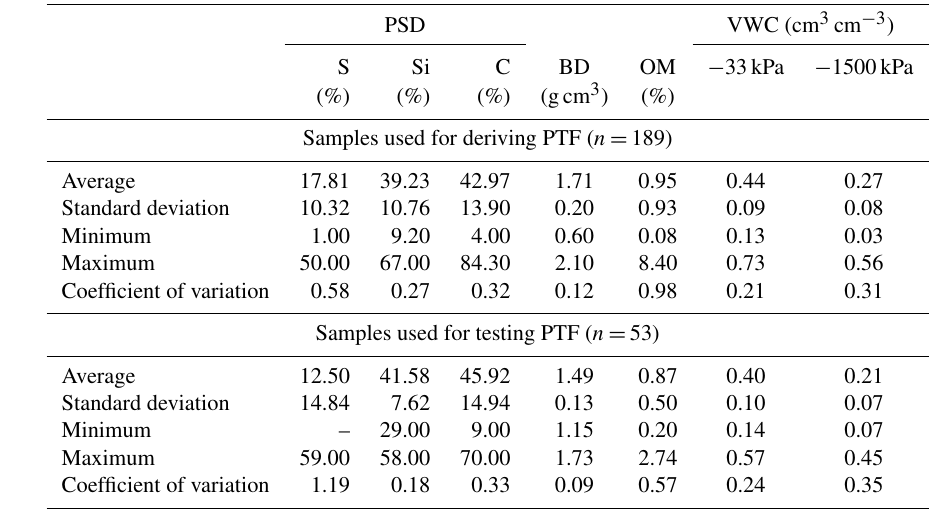
Table 1. Soil characteristics of the developed and validated